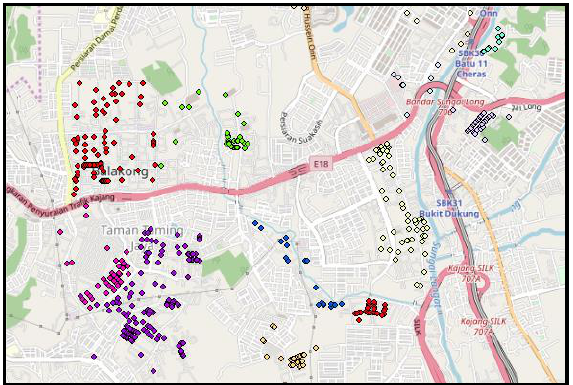
Figure 6 Data preparation for network analysis